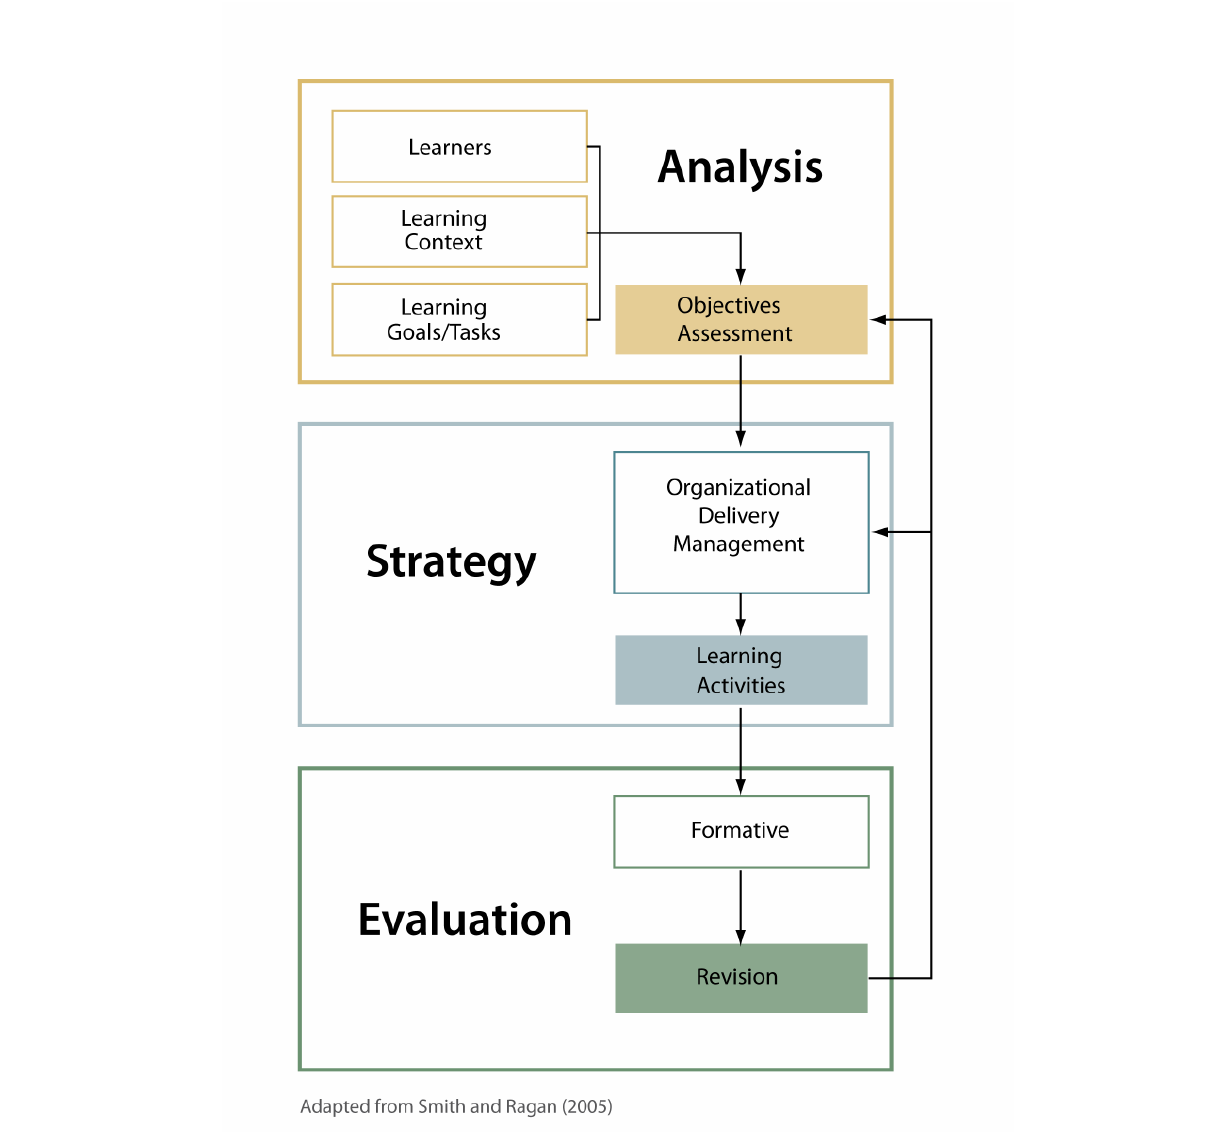
Figure 1. Smith and Ragan’s instructional design process model.